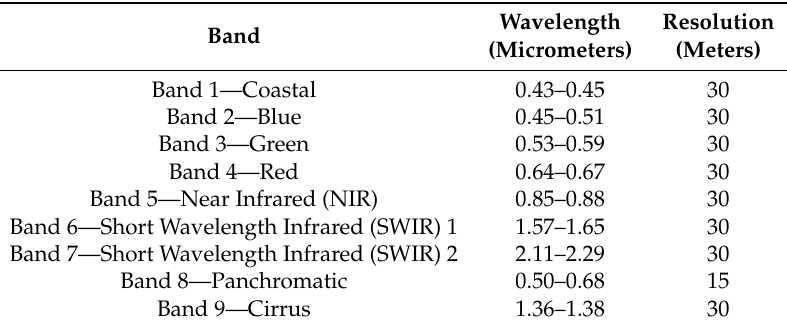
Table 1. Landsat 8 OLI spectral